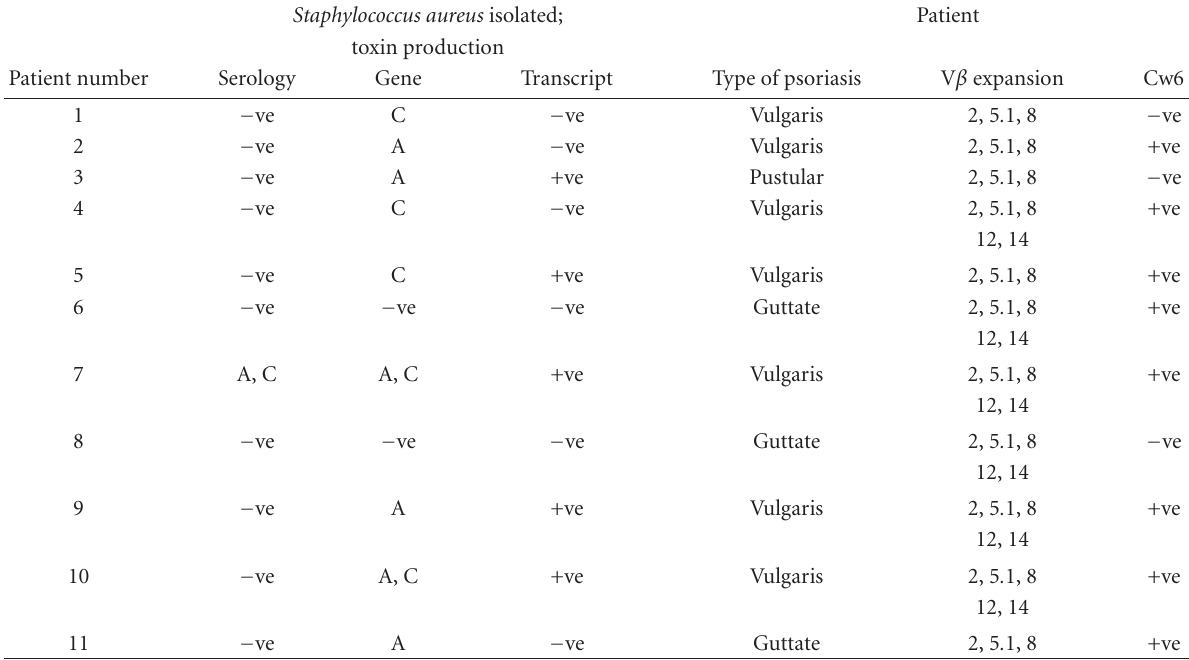
Table 1. Toxin production by Staphylococcus aureus isolates, and Cw6 allele and V β expansions in patients with psoriasis.